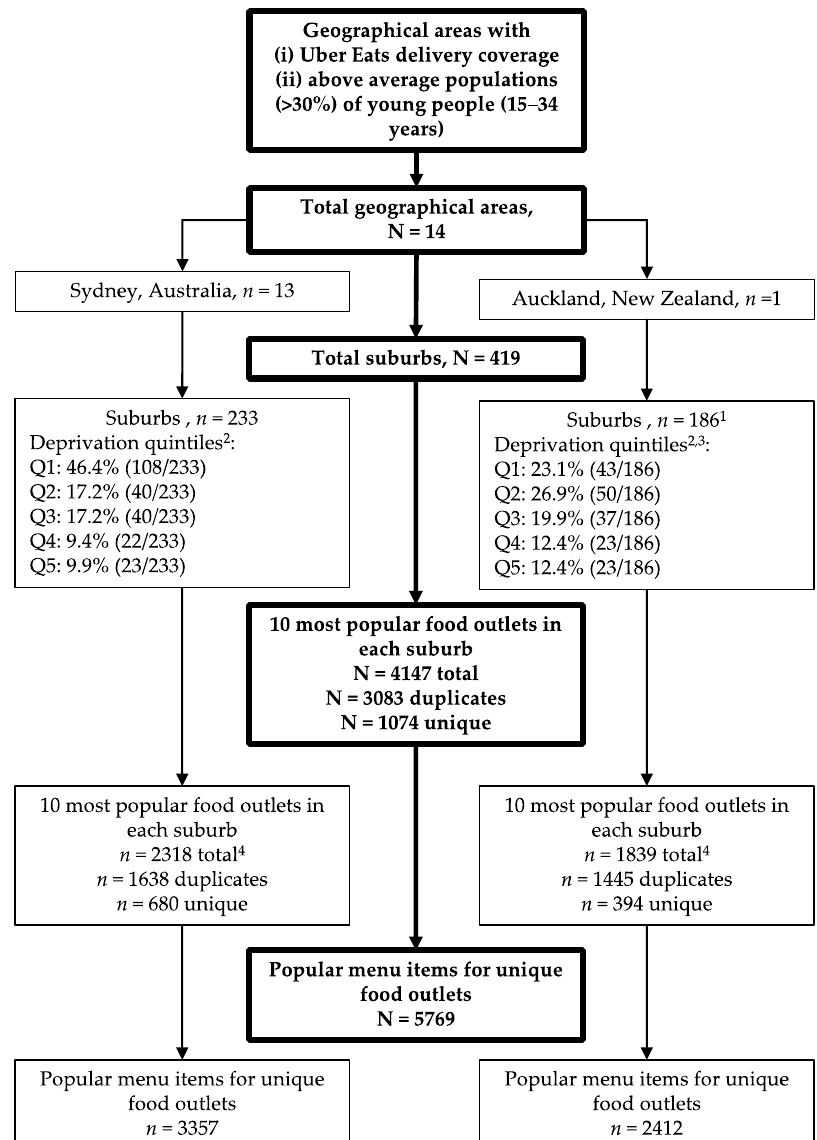
Figure 1. Flow diagram of included unique food outlets and most popular menu items in Sydney, Australia and Auckland, New Zealand. 1 Suburbs with the Uber Eats Auckland service area; 2 Q1 least disadvantaged suburbs and Q5 most disadvantaged suburbs; 3 Ten Auckland suburbs did not have a dep index available (10 / 186, 5.4%); 4 Nine suburbs had less than ten most popular food outlets.